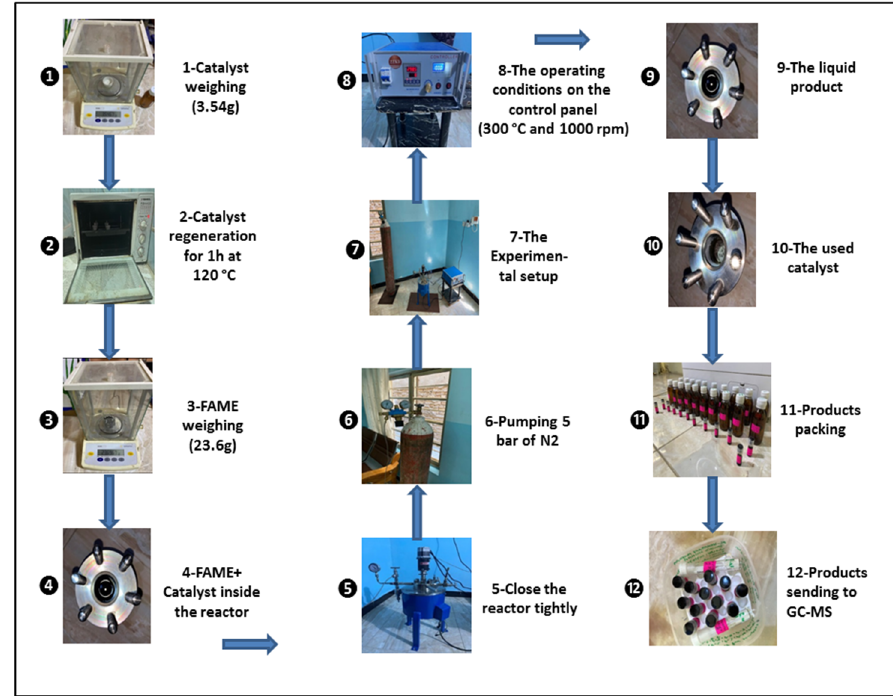
Figure 4. Schematic diagram of the used batch reactor.